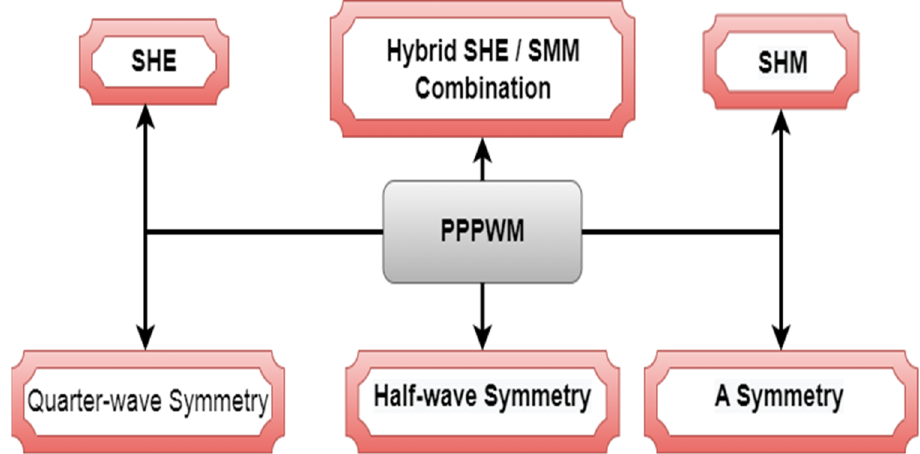
Figure 16. PPPWM common classification types and formulations.